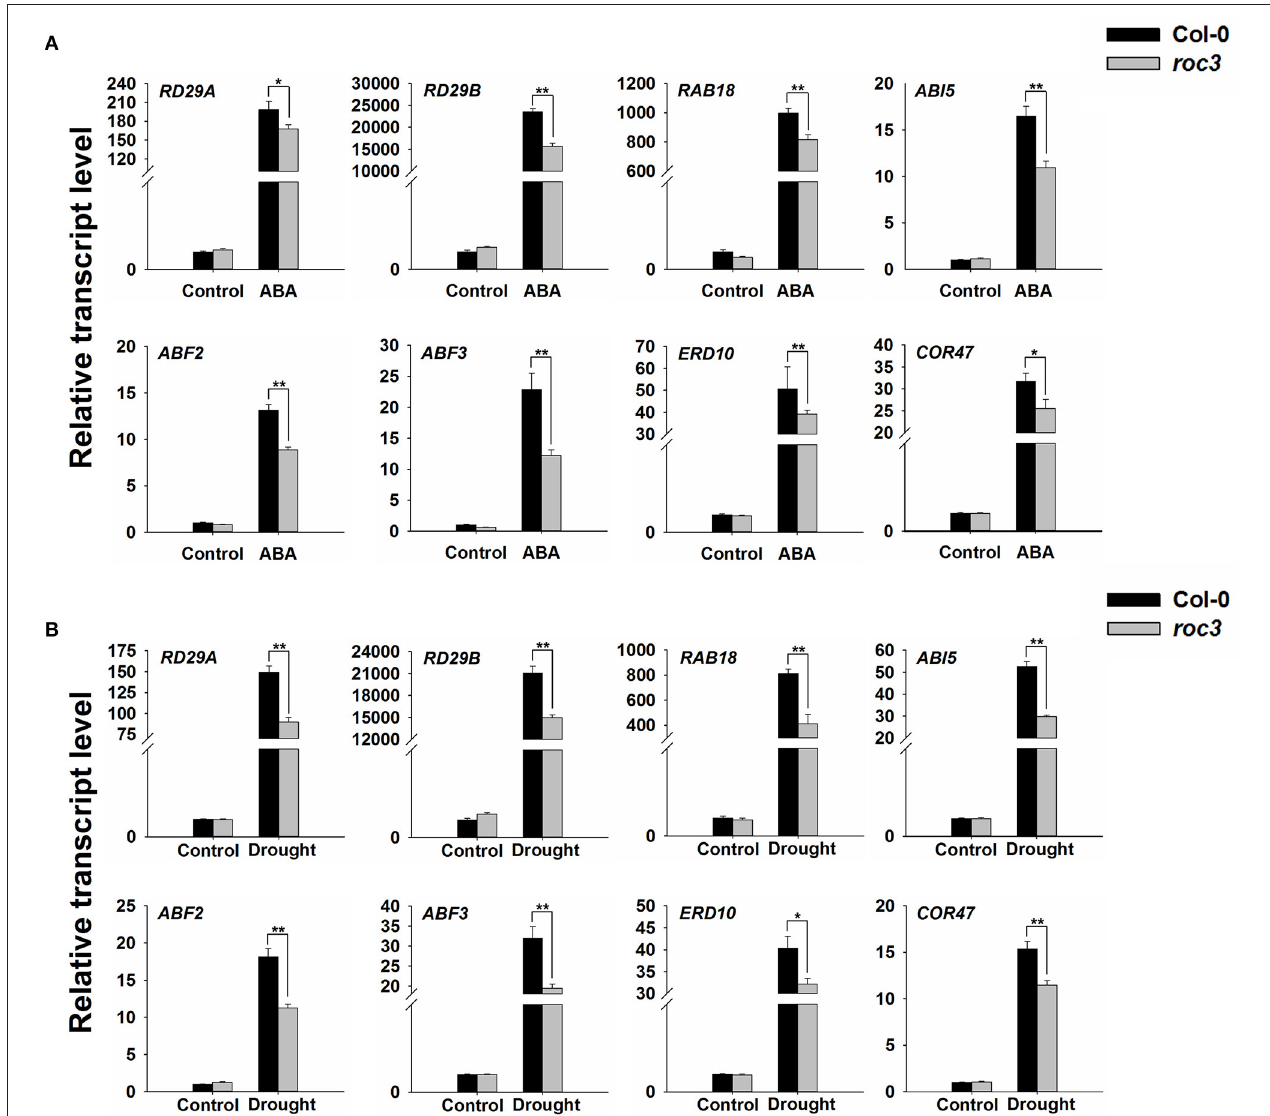
FIGURE 7 | Transcriptional profiling of the indicated genes associated with the stress response in roc3 mutant exposed to either ABA treatment or drought stress. Relative transcript abundances assessed using qRT-PCR in plants subjected to (A) 6h exposure to ABA, (B) 6h exposure to drought stress. Means shown in the form mean ± SE ( n = 3), *, **: means differed significantly from control treatment ( P < 0.05,